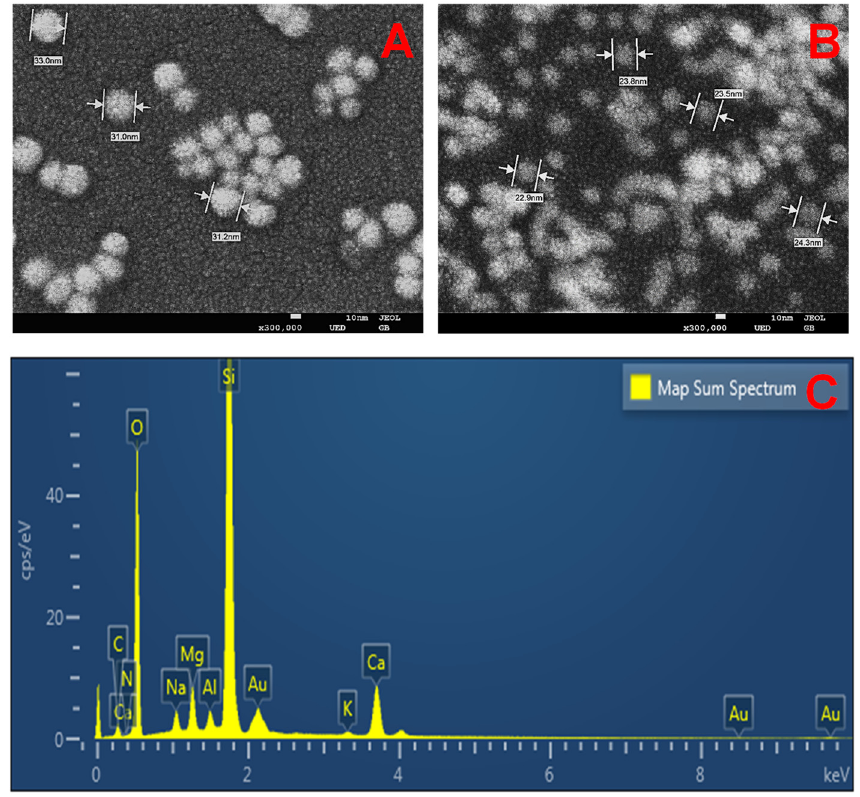
Figure 2. SEM images of HA-reduced AuNPs at 1/2 ( A ) and 1/3 ( B ) HA/Au 3+ molar ratios. Scale bar = 10 nm. ( C ): EDX spectrum of HA-reduced AuNPs at 1/2 HA/Au 3+ molar ratio.